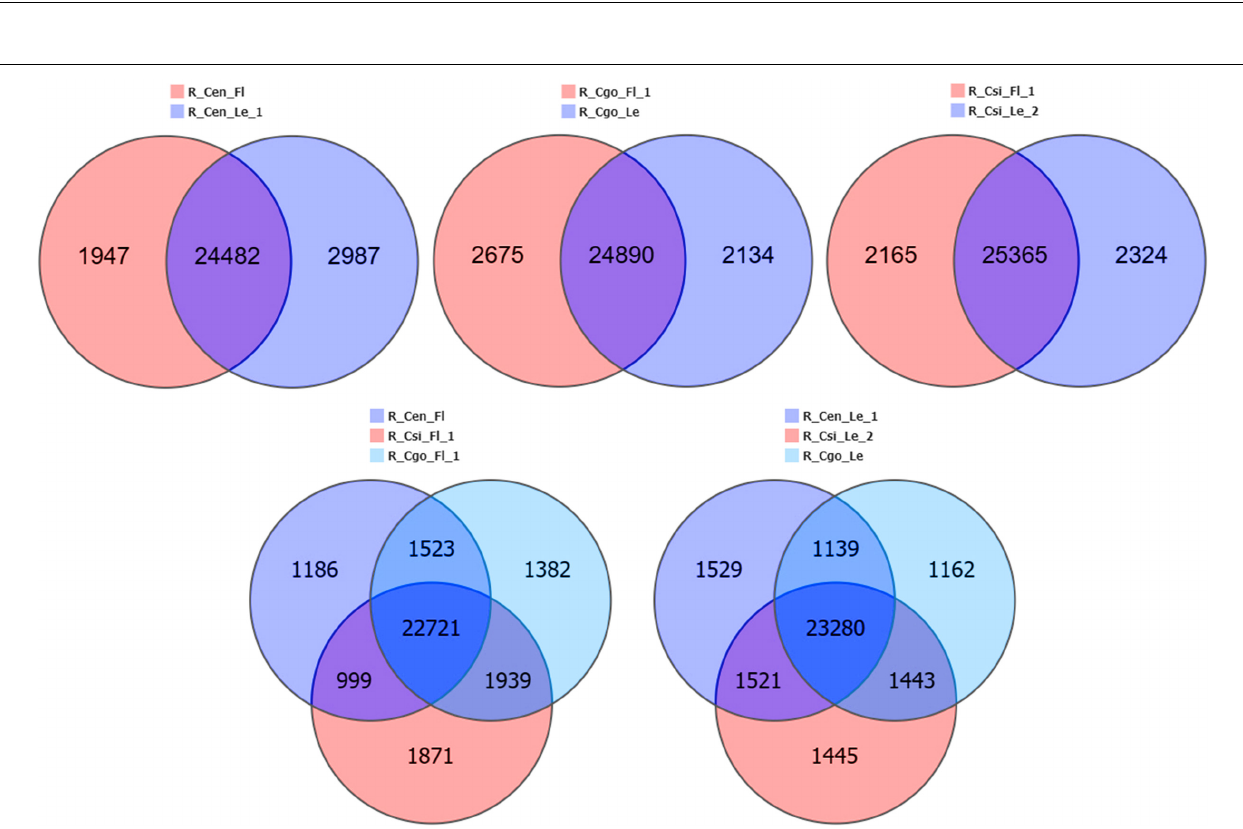
Frontiers in Plant Science |